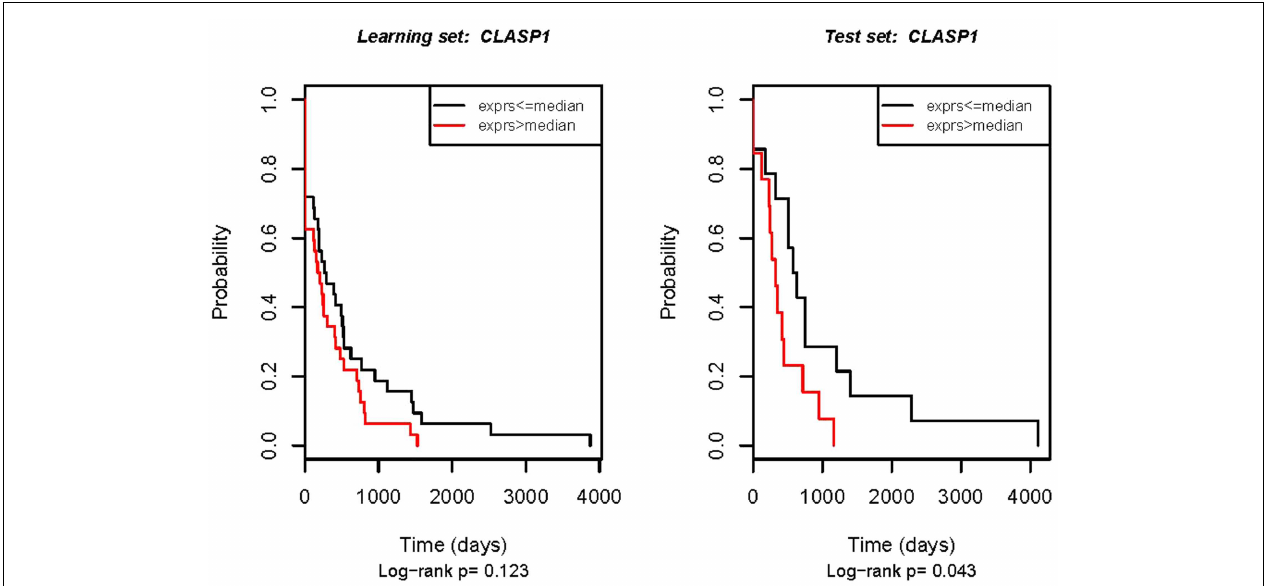
the independent patient group.The Kaplan–Meier analysis plot of observed DFS for patients with ovarian cancer by log-rank test according to real-time RT-PCR estimated gene